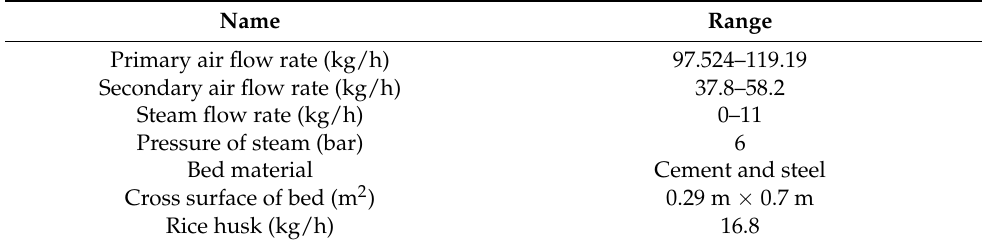
Table 2. The operating conditions for the experimental process.